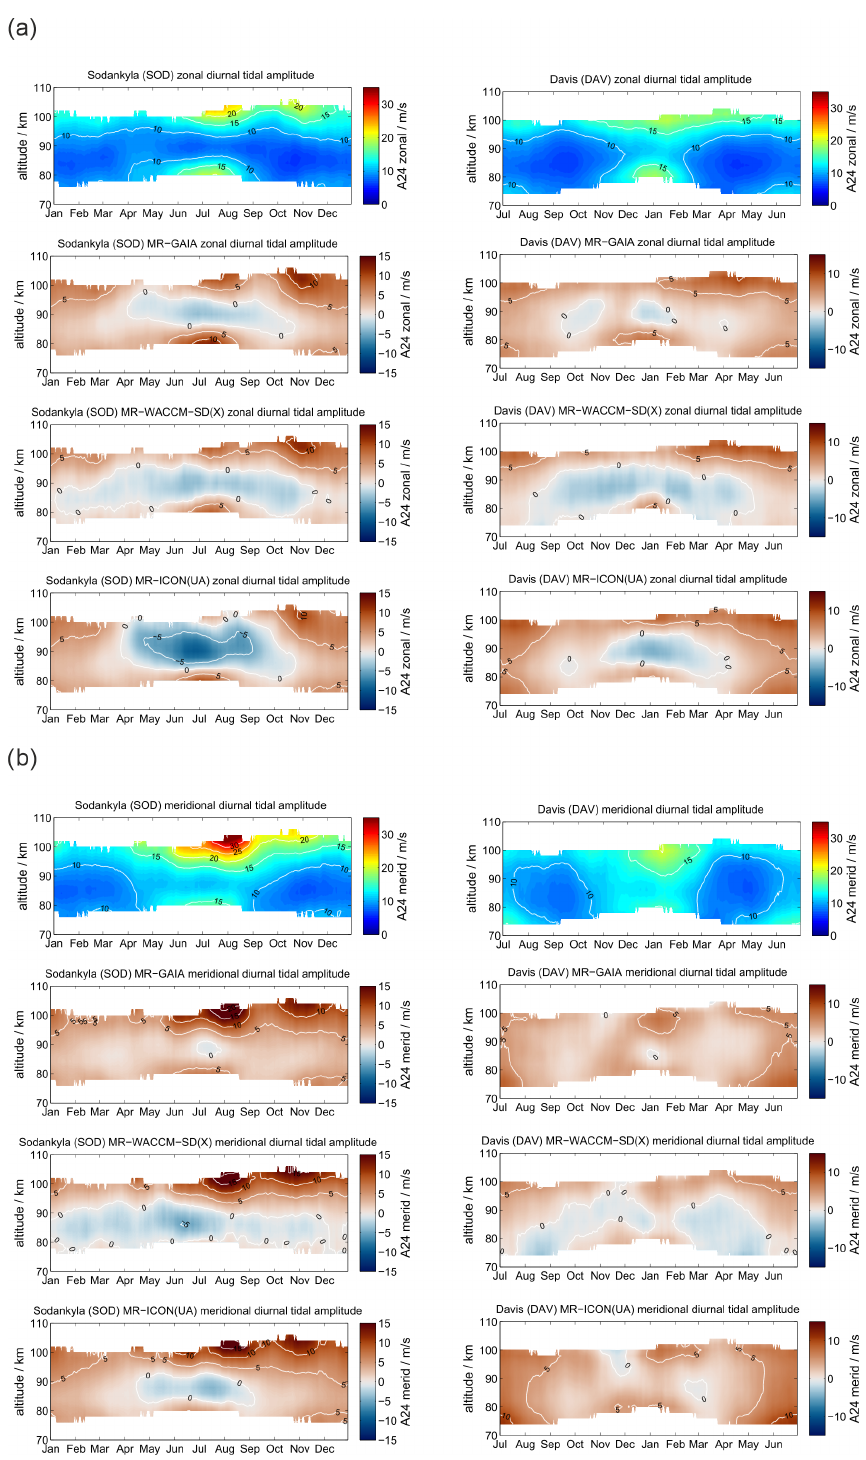
Figure C1. Absolute difference plots for diurnal tidal amplitudes from meteor radar and model fields for SOD and